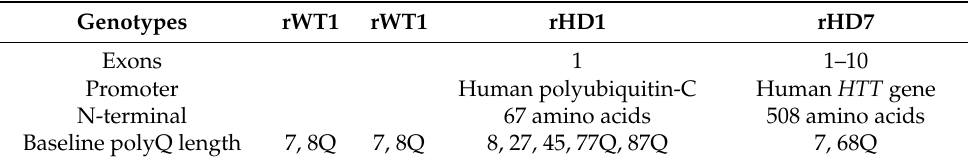
Table 1. Genotypes of nonhuman primates used in this